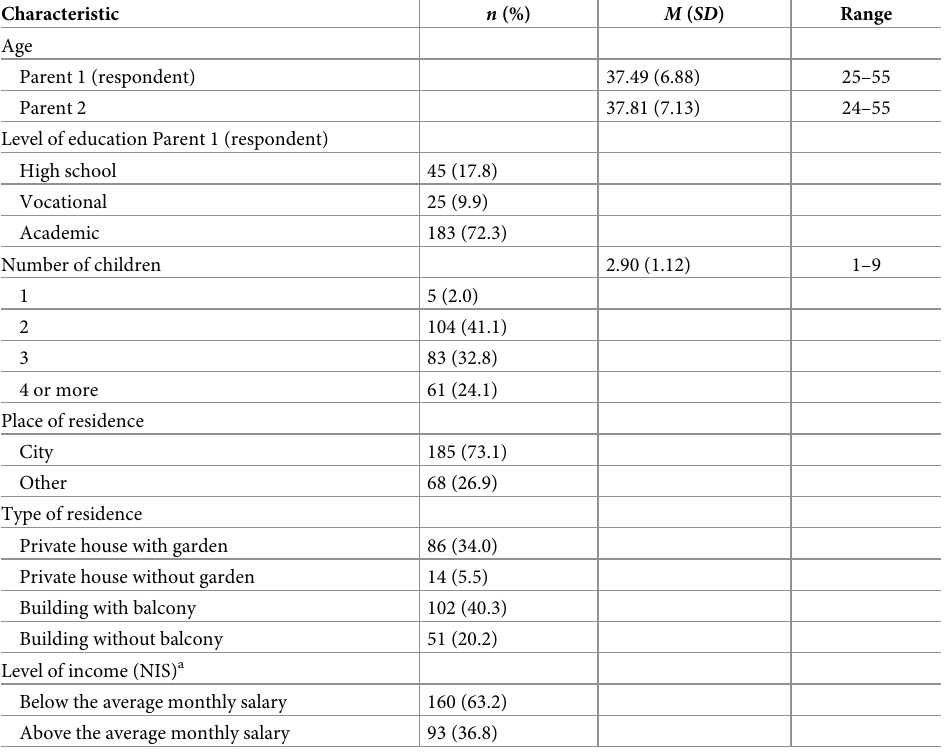
Table 1. Means, standard deviations, ranges, and frequencies for the sample’s demographic